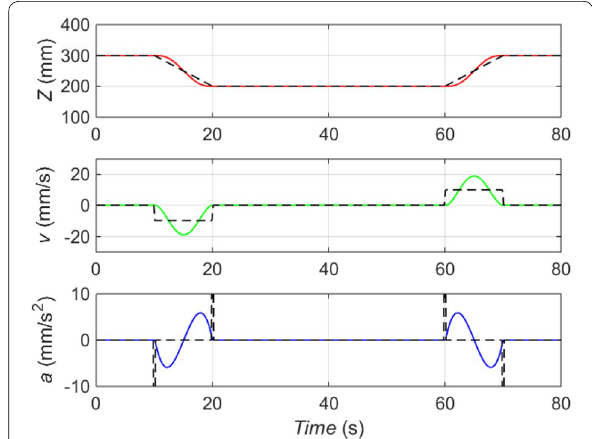
Figure 5 Position, velocity, and acceleration curves of fifth degree polynomial planning in the Y direction